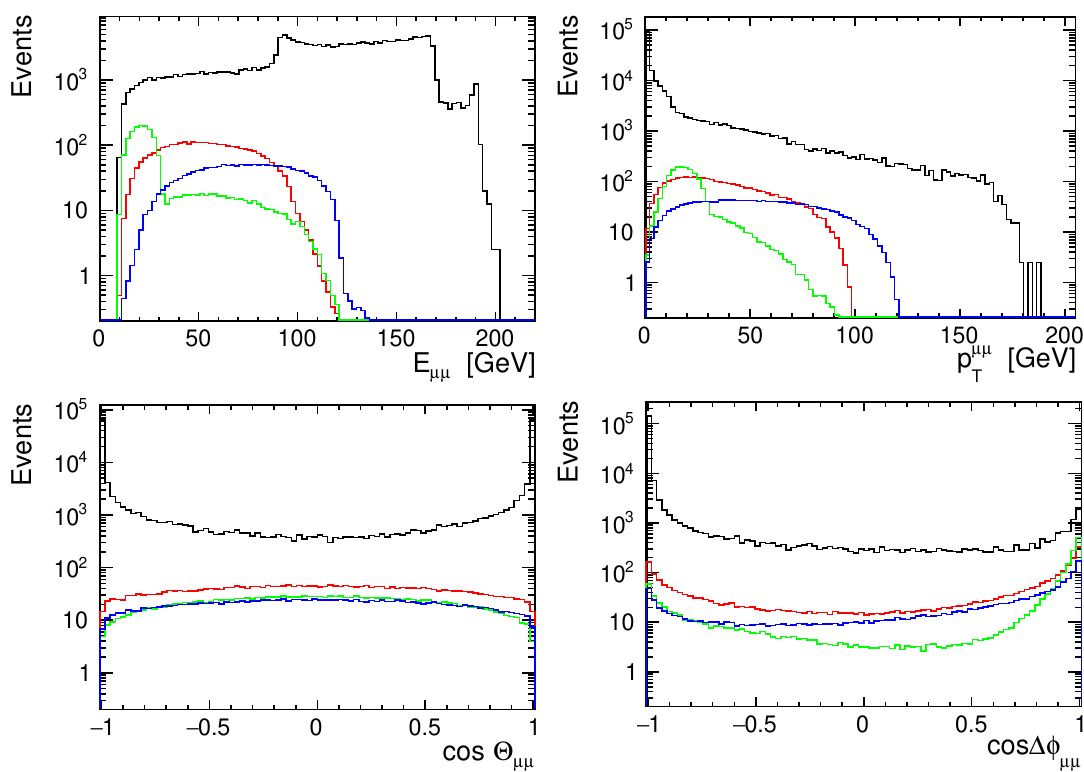
Figure 3 . Distributions of the kinematic variables describing the leptonic (cid:12)nal state considered in AH analysis: lepton pair energy, E (cid:22)(cid:22) , total transverse momentum, p (cid:22)(cid:22) cos (cid:2) (cid:22)(cid:22) and the di(cid:11)erence of the lepton azimuthal angles, cos (cid:1) (cid:30) (cid:22)(cid:22) . Expected distributions for representative benchmarks BP1 (red histogram), BP2 (green) and BP7 (blue) are compared with expected background (black histogram). Samples simulated for CLIC running at 380 GeV are normalised to 1 ab (cid:0) 1